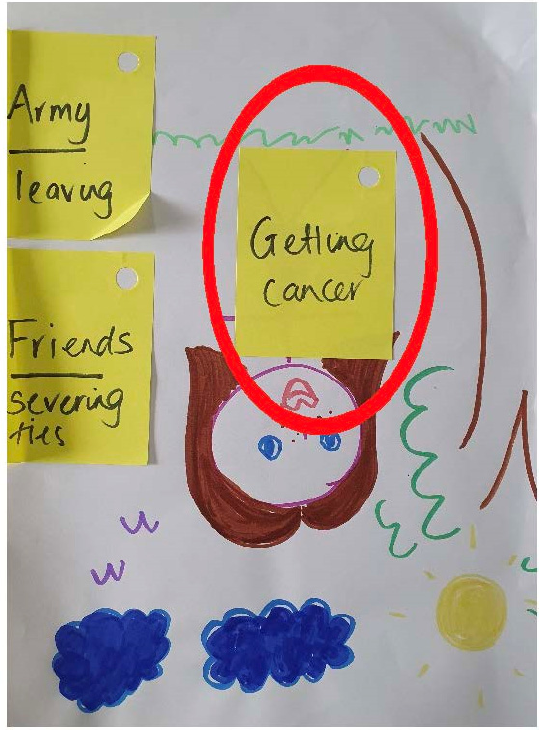
Figure 4. Child’s relative worries (Huxley; male*: 17 years). * not a self-portrait, this participant preferred to use the researcher’s drawing.